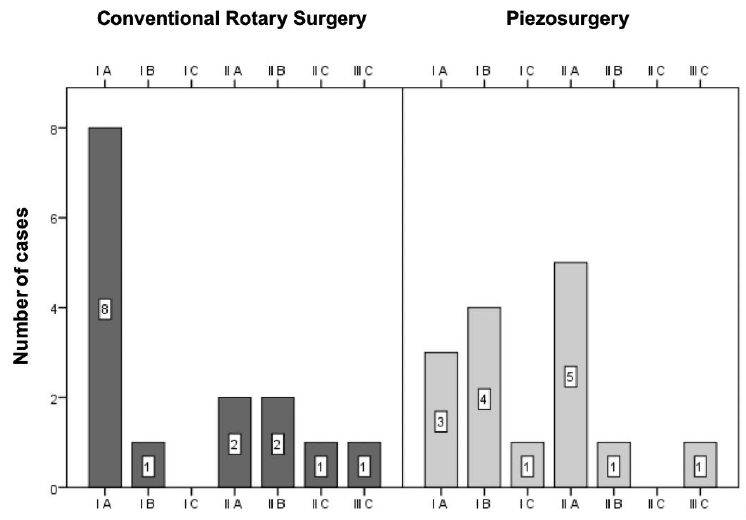
Figure 2. Sample distribution according to the Pell and Gregory classification ( p = 0.247 for the com- parison between the two techniques).